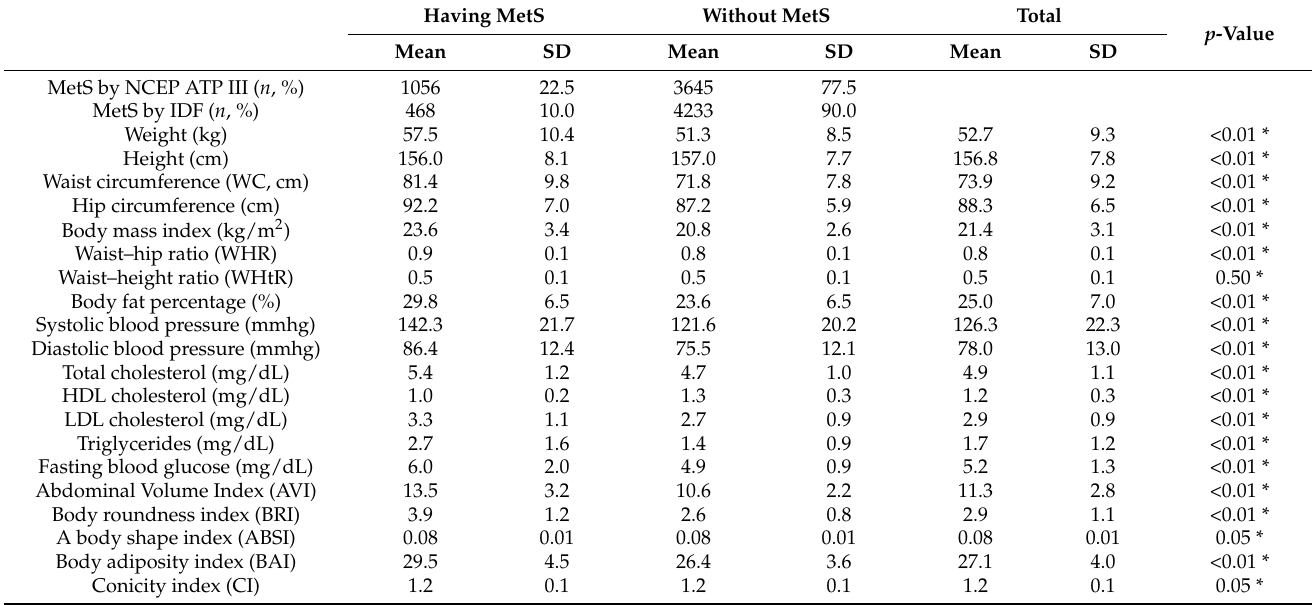
Table 2. Baseline anthropometric and laboratory characteristics of participants by metabolic syndrome condition using National Cholesterol Education Program, Adult Treatment Panel III (NCEP ATP III) criteria.